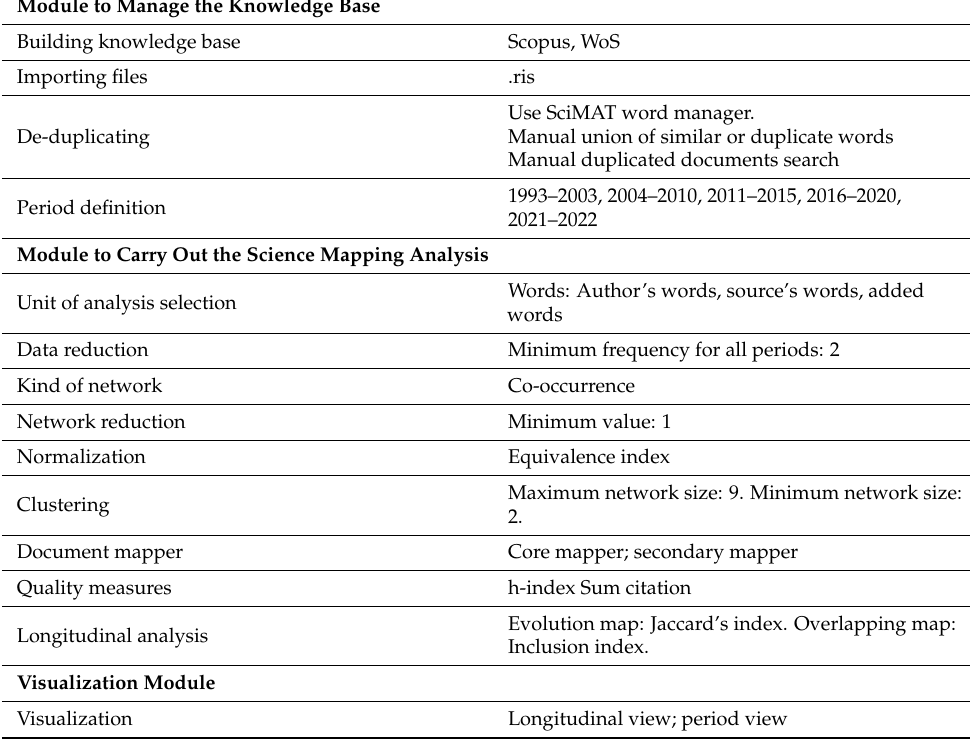
Table A1. Mapping energy sector from risk management research perspective—selected analysis parameters in SciMAT